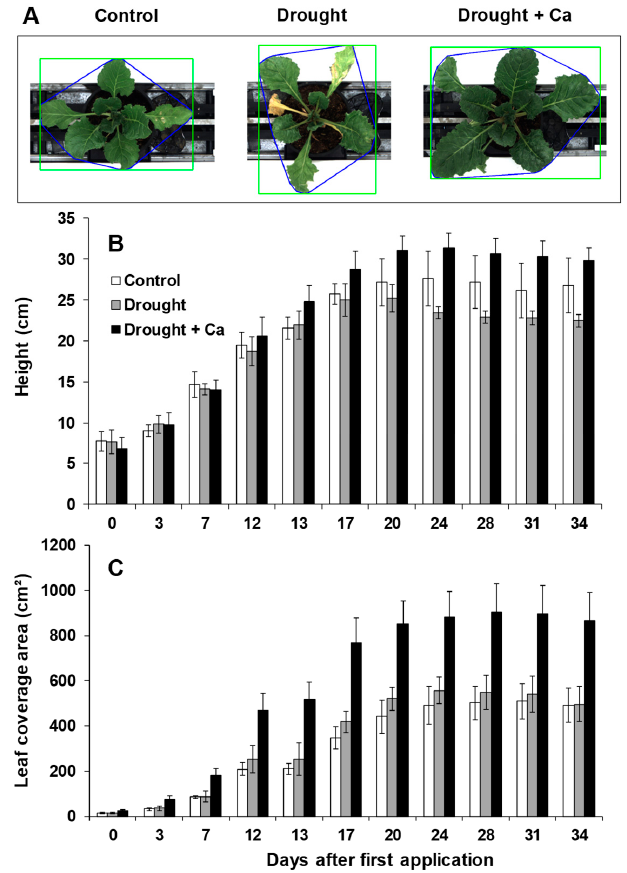
Figure 2. Influence of foliar application of Ca 2+ on sugar beet leaf coverage area shape and height under drought stress. ( A ) Representative image-based detection of leaf coverage area; ( B ) plant height estimation based on lateral imaging; and ( C ) leaf coverage area. Plants were grown in pots for a duration of 8 weeks. Five-week-old sugar beet plants were kept at 90% field capacity as control or exposed to drought stress (30% field capacity) for a duration of 3 weeks. Ca 2+ was applied at BBCH14 and BBCH18 in concentration of 5 L ha − 1 corresponding to 540 g Ca ha − 1 . Plants were imaged every four days from first Ca 2+ application. Bars indicate means ± SD.